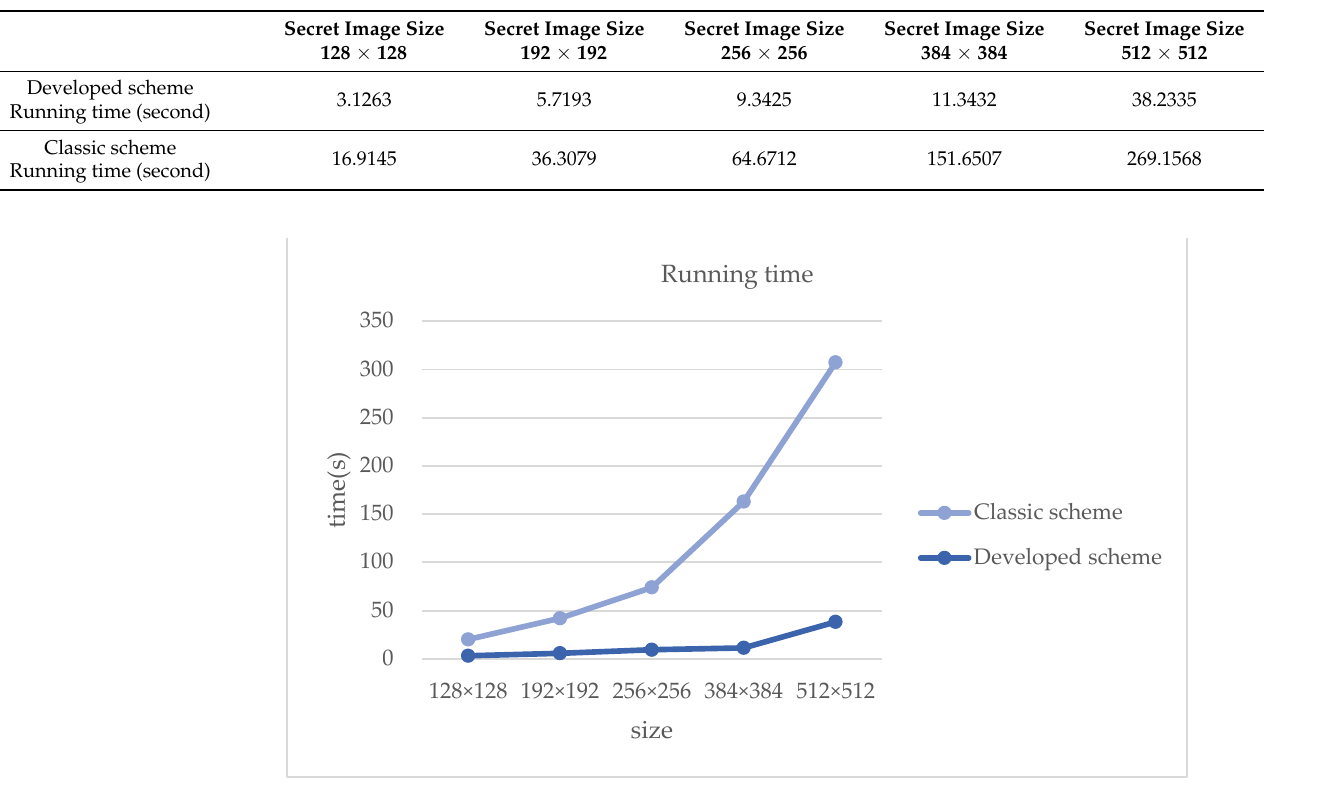
Table 4. Running times with different sizes in GF (251).